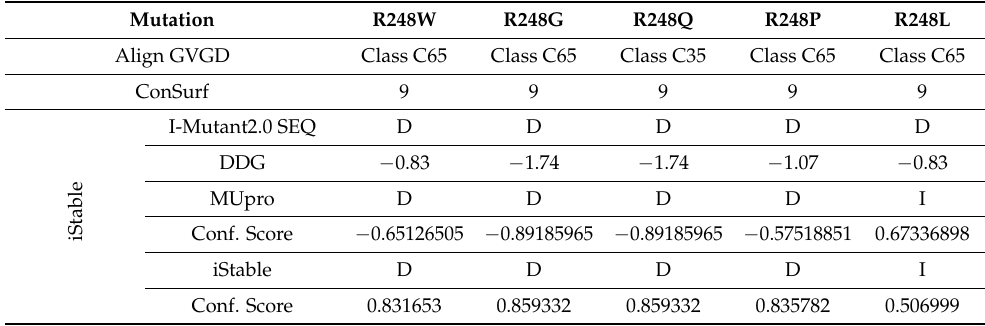
Table 2. The biophysical characterization, evolutionarily conservation, and stability analysis of R248 mutations in p53 protein using Align GVGD, Consurf, and iStable